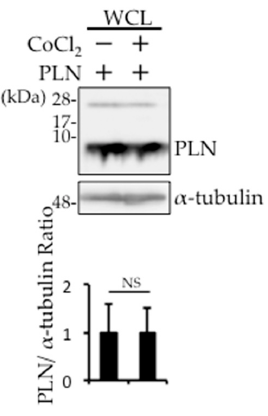
Figure 3. PLN was degraded by the disturbance in the mitochondrial membrane potential through an increase in the oxidative stress. ( a , b ) PLN-transfected HEK293 cells were harvested 4 h after treatment with 20 μ M carbonylcyanide m -chlorophenylhydrazone (CCCP) with or without 5 mM N -acetyl- L -cysteine (NAC). Western blot analysis of whole cell lysates ( a ) and pVHL pull-down fractions ( b ) from PLN-transfected HEK293 cells was performed using an anti-PLN antibody. The bar graph indicates the intensity of PLN bands, as measured by ImageJ (Version 1.50i, National Institutes of Health, Bethesda, MD, USA) ( n = 3). A value of p <0.05 (*) was considered significant. ( c ) PLN-transfected HEK293 cells were harvested 4 h after treatment with 125 μ M CoCl 2 . Western blot analysis of whole cell lysates was performed using an anti-PLN antibody. The bar graph indicates the intensity of PLN bands, as measured by ImageJ ( n = 3). NS: not significant.